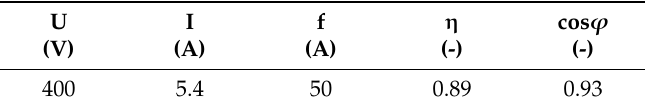
Table 1. Data of LSPMSM for T L = 19.5 Nm.